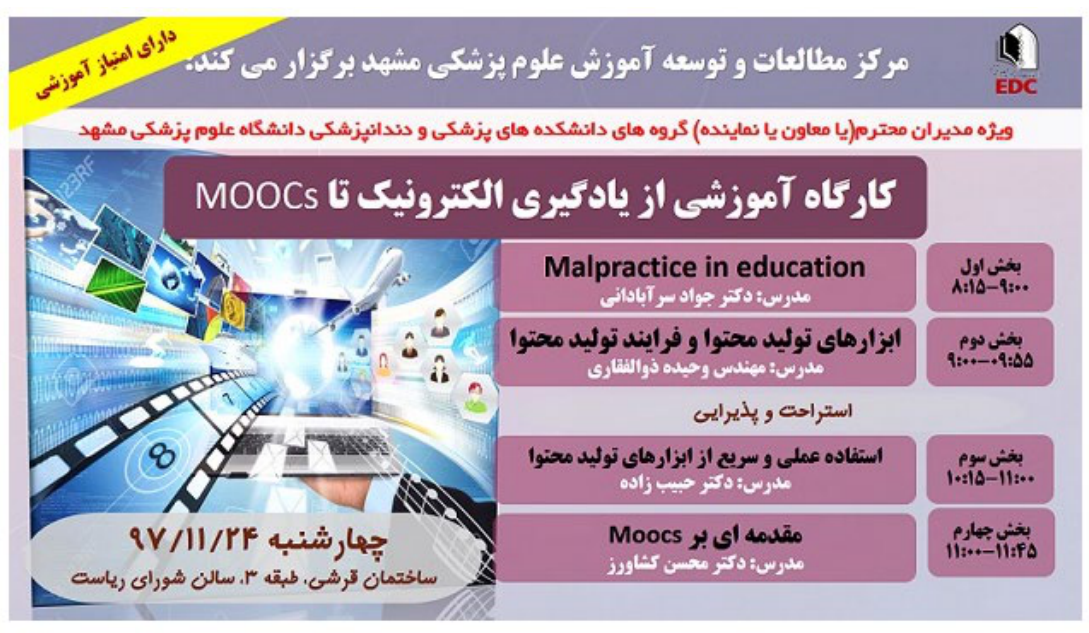
Introduction on MOOCs Workshop